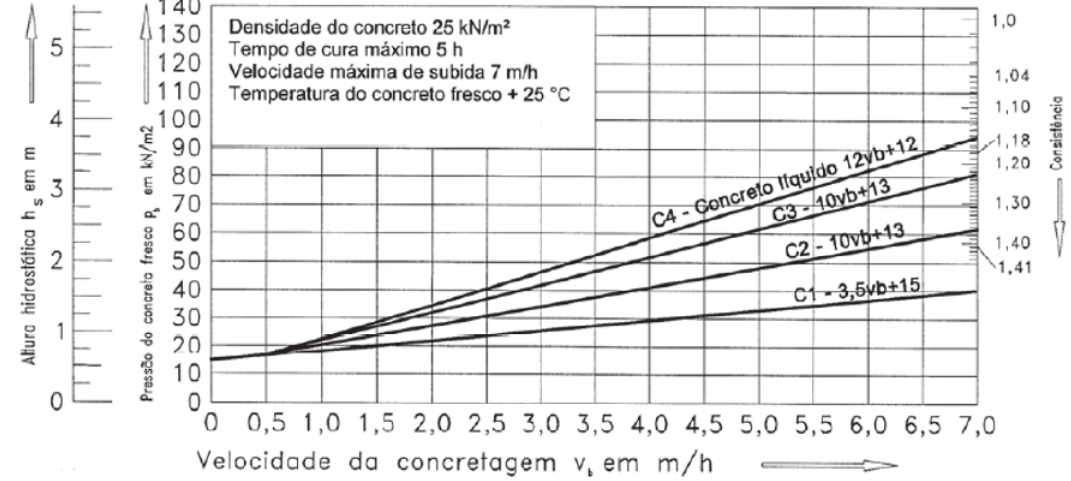
Diagrama para determinação da pressão lateral do concreto fresco e altura hidrostática correspondente, em função da velocidade da concretagem e da consistência Fonte: NBR 15696 [9]